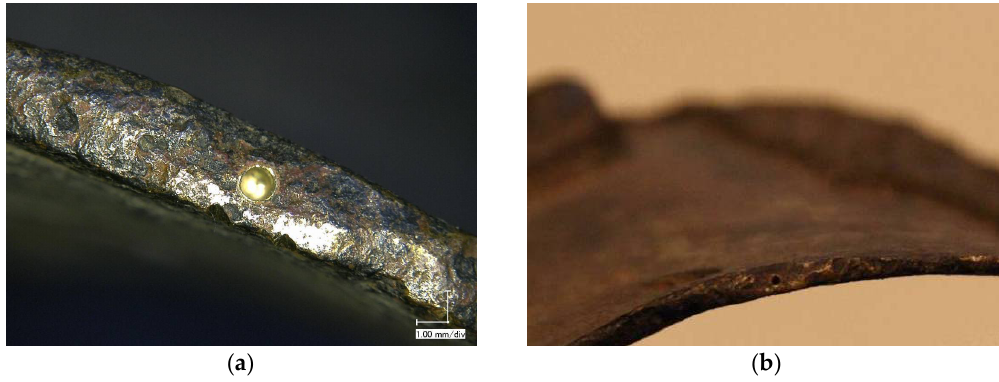
Figure 7. Documentation of sample location (object 1), Oni Head, alleged Ife provenance, the photo ( a ) on the left is a macroscopic detail of the overview photo ( b ) on the right.